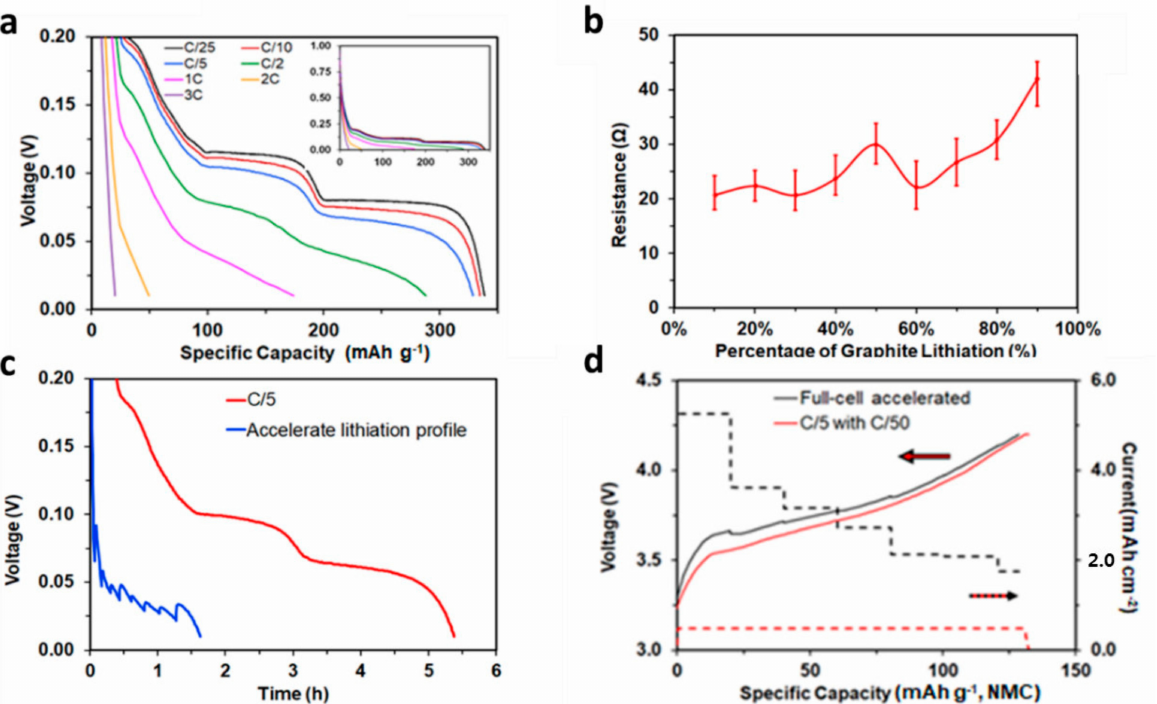
Figure 1. ( a ) Voltage profiles for MCMB half-cell at various lithiation rates from C/25 to 3C. ( b ) Resulting resistance calculated from polarization in ( a ). ( c ) Graphite half-cell voltage profiles of C/5 and accelerated lithiation. Shown is the reduction in graphite lithiation time compared to C/5 current resulting from applying accelerated lithiation protocol. ( d ) Full lithium ion cell with 1.2:1 N:P current and voltage profiles for C/5 and accelerated charge rates. Reproduced with permission from J. Electrochem. Soc., 166 (8) A1432-A1438